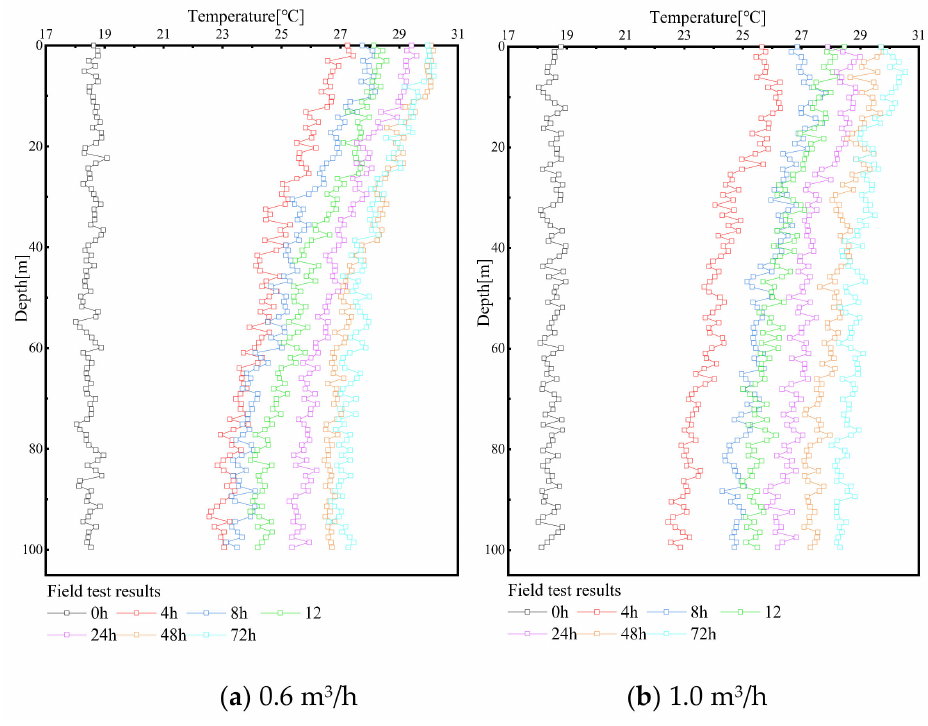
Figure 13. Variation of the temperature of the #2 pile inlet pipe with time under different flow